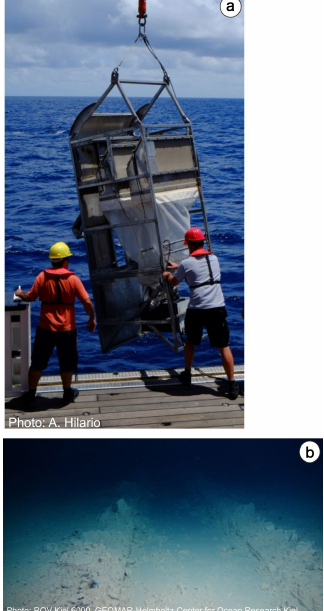
Figure A3. (a) The epibenthic sledge that created the monitored sediment plume (photo: Ana Hilario) (Brenke, 2005). (b) Track created by the EBS at the seafloor, approximately 20cm deep and 1.5m wide (photo: ROV Kiel 6000, GEOMAR Helmholtz Centre for Ocean Research Kiel).